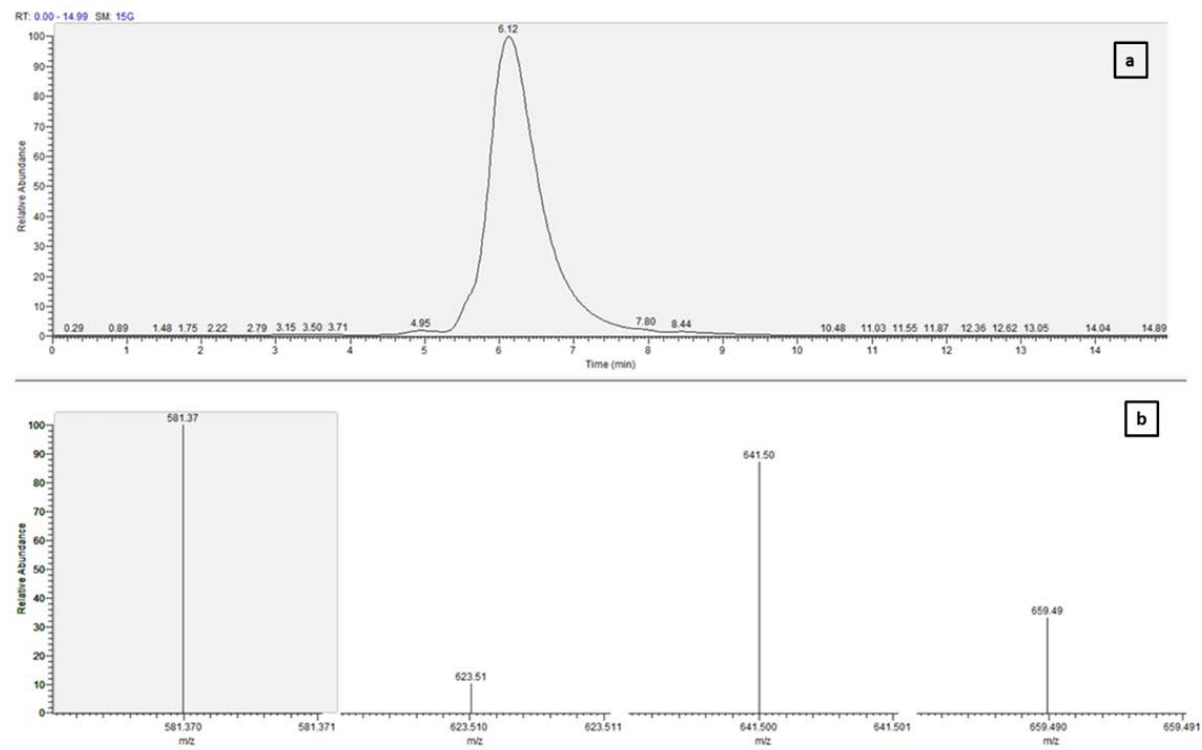
Figure 9. Liquid chromatography mass spectrometric data for fucoxanthin ( a ) LC chromatogram and ( b ) LC–MS/MS spectra for fucoxanthin purified from N. shiloi after preparative